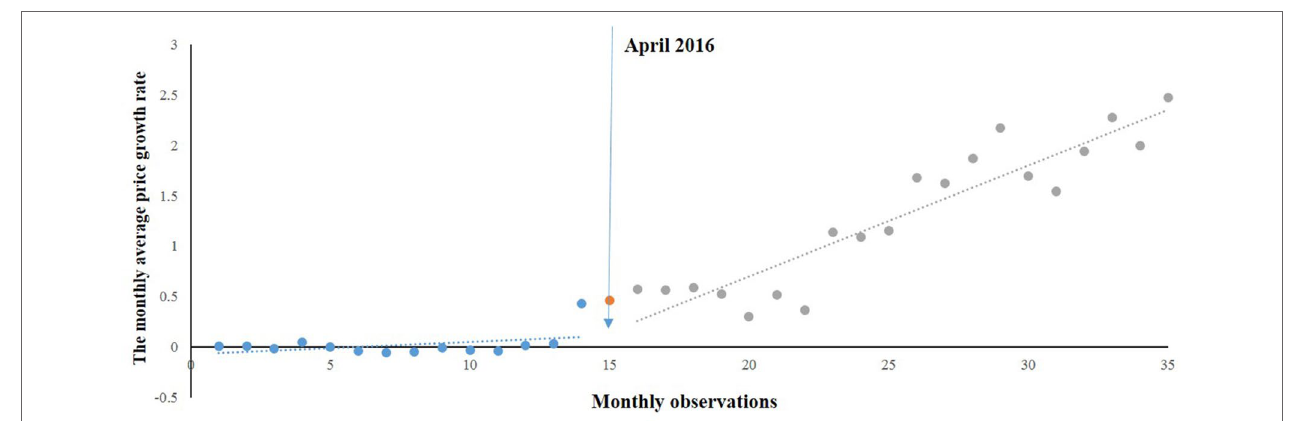
FIGURE 3 | Segmented regression model showing MPRg from 2015 to